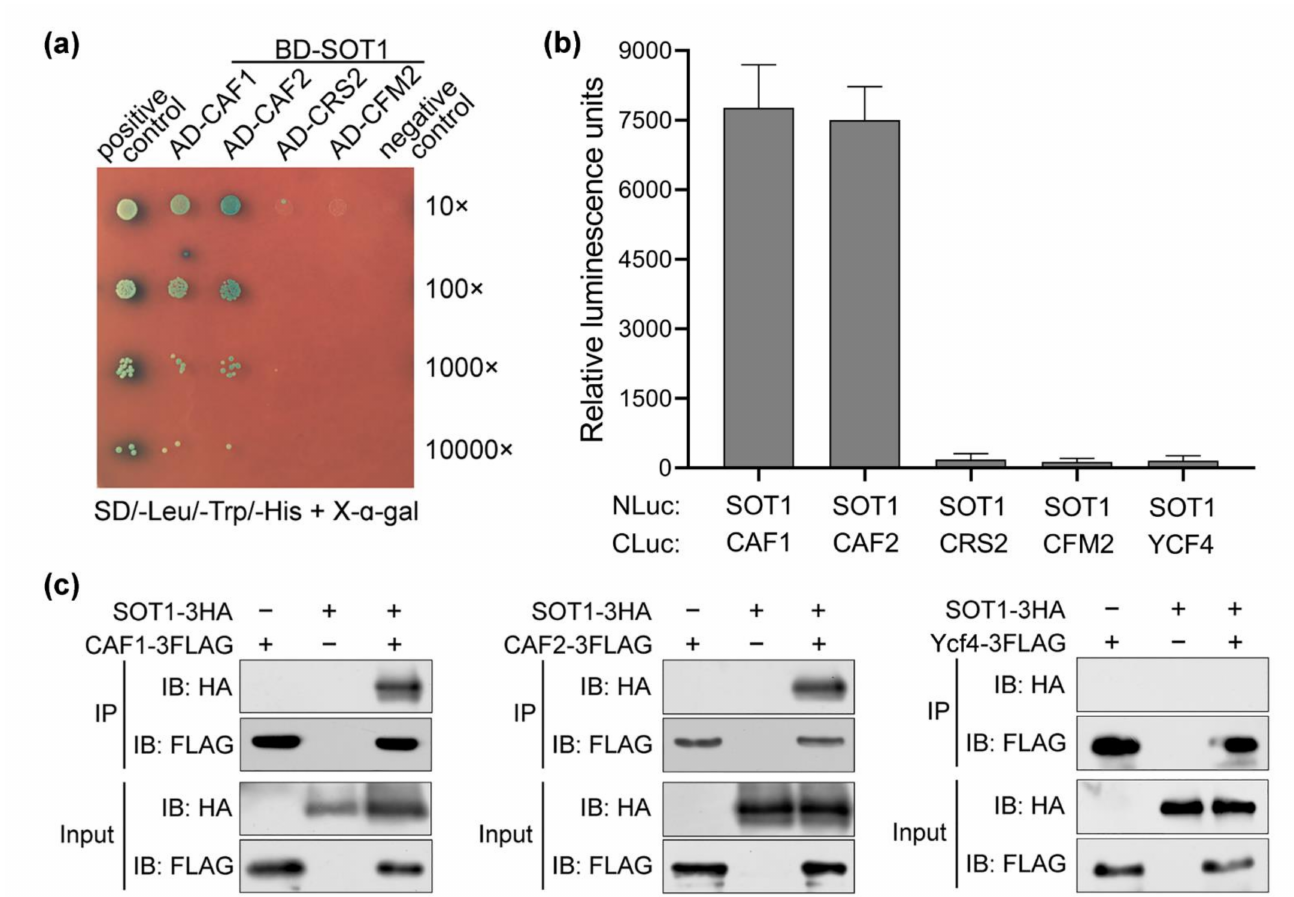
Figure 5. SOT1 directly interacts with CAF1 and CAF2. ( a ) Yeast two-hybrid assays indicate that SOT1 interacts with CAF1 and CAF2. SOT1 was fused to the BD vector; CAF1 (or CAF2, CRS2, and CFM2) was fused to the AD vector. The ability to grow on SD/-Trp-Leu-His-Ade dropout plates indicates an interaction between the two proteins. ( b ) Luciferase complementation assay for interactions between SOT1 and CAF1 versus CAF2. The indicated NLuc and CLuc constructs were transiently coexpressed in Nicotiana benthamiana plants through Agrobacterium-mediated transformation, and the luciferase (Luc) activity was measured after 48 h. Error bars indicate SD ( n = 4). ( c ) Coimmunoprecipitation assays showing the interaction of SOT1 with CAF1 or CAF2. 3 × HA-tagged SOT1 and 3 × FLAG-tagged CAF1 (or CAF2) were coexpressed in Arabidopsis protoplasts. Protein complexes were immunoprecipitated (IP) using an α -FLAG antibody. Immunoblot (IB) analysis of the protein presence in the immunoprecipitates using the α -FLAG and α -HA antibodies, respectively. The assay of interaction between SOT1 and Ycf4 was used as a negative